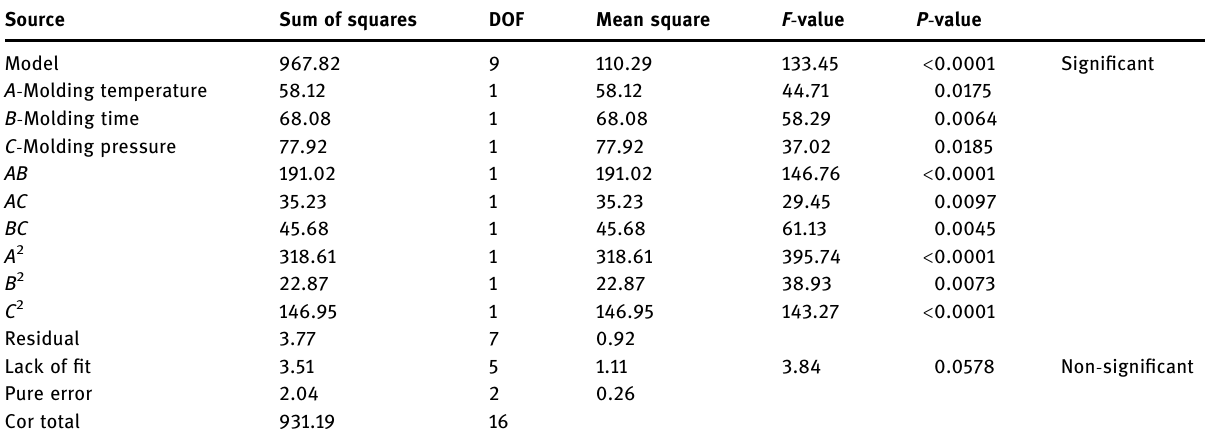
Table 11: ANOVA for tear strength Source